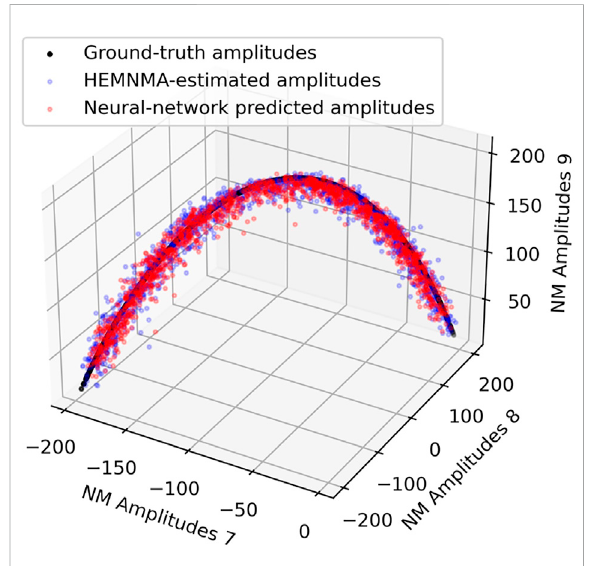
FIGURE 6 Overlap between inferred, ground-truth, and HEMNMA- estimated values of conformational parameters (normal-mode amplitudes) for a small test set of 2,000 synthetic images. Each point corresponds to an image and a molecular conformation inside it. Close points correspond to similar conformations and vice versa. For 2D scatter plots of the normal- mode amplitudes, see Supplementary Figure S2. See also Tables 1, 2.